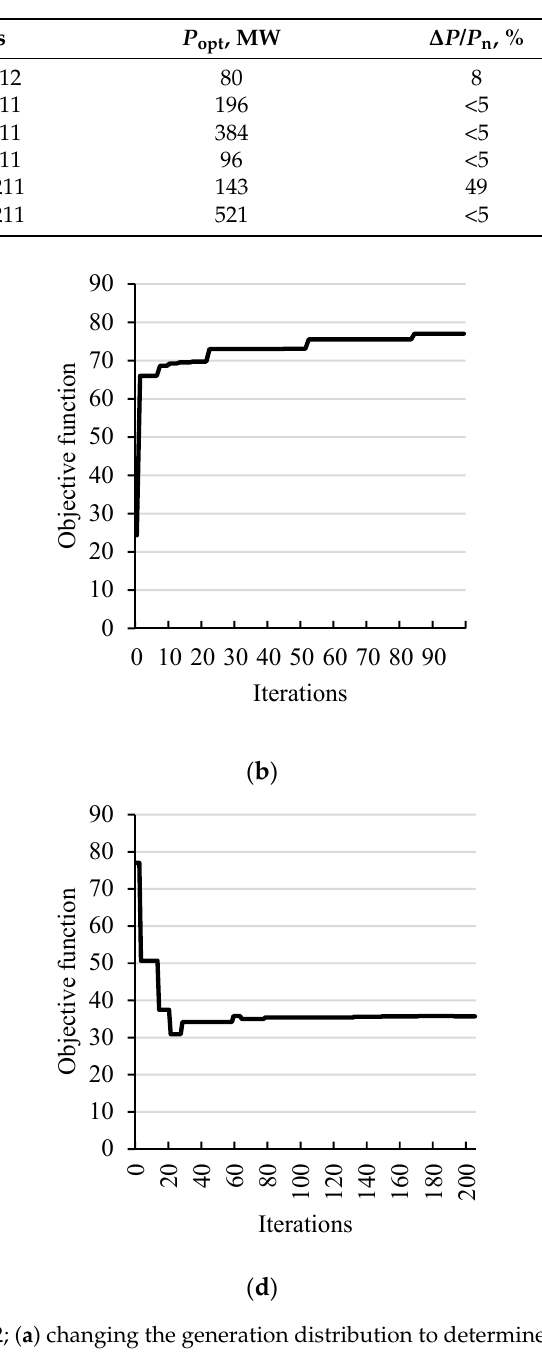
Table 5. List of sources with optimal capacity and expected values of power surges calculated for each generator.